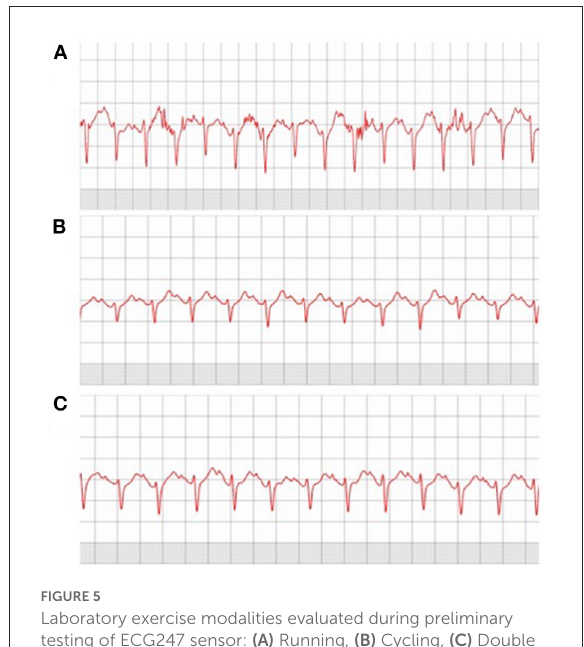
FIGURE5 Laboratory exercise modalities evaluated during preliminary testing of ECG247 sensor: (A) Running, (B) Cycling, (C) Double poling XC.